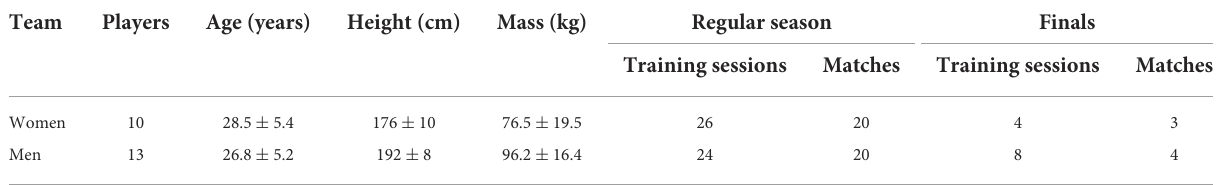
TABLE 1 Participant